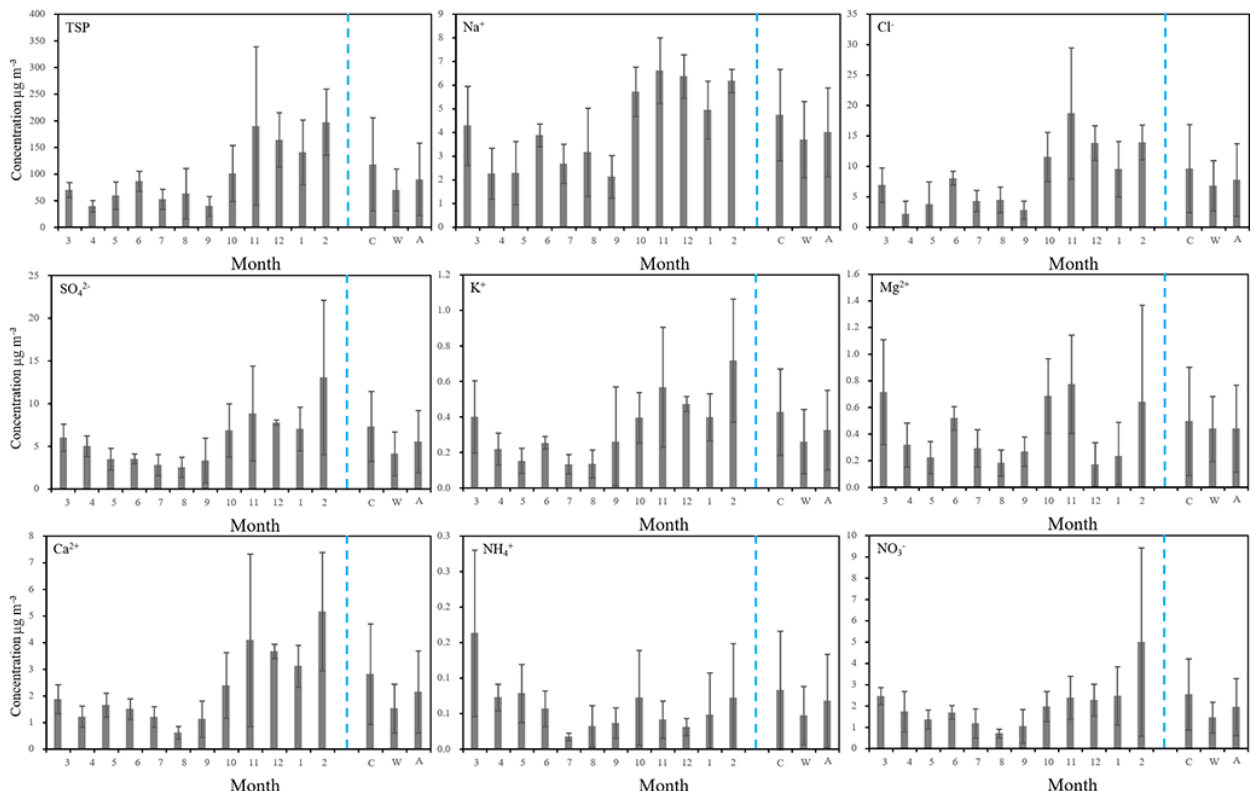
Figure 6. Seasonal variations of TSP mass concentrations and associated species, including Na + , Cl − , SO 2 − NO − at Yongxing Island (cool season: C; warm season: W; annual: A). Shown are the mean and standard deviation for each 3